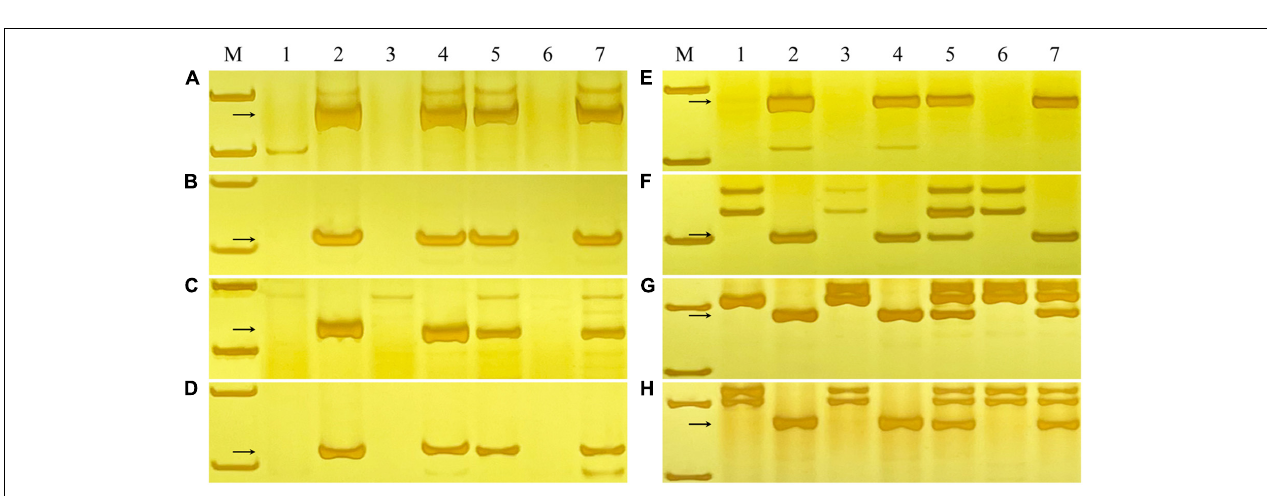
FIGURE 3 | Evaluation of powdery mildew resistance at the adult plant stage and molecular detection of the 6R chromosomes from YT2 using 6RS-specific marker SW22057 (A) and 6RL-specific marker SW22063 (B) in F 2 plants of YT2 × Gao 8901. Lanes M, pUC19 Msp I. 1, YT2; 2, Gao 8901; and R, resistant; S, susceptible F 2 plants. The arrows indicate the diagnosed amplified fragments.